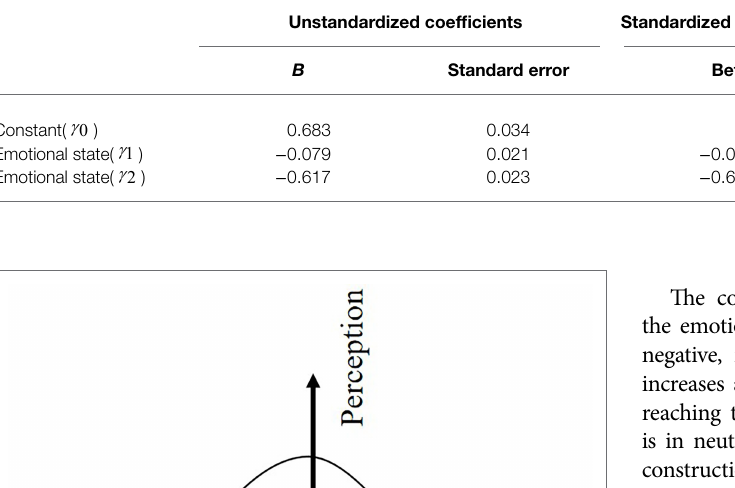
TABLE 13 | Coefficients between perception level of safety hazard and emotional valence.